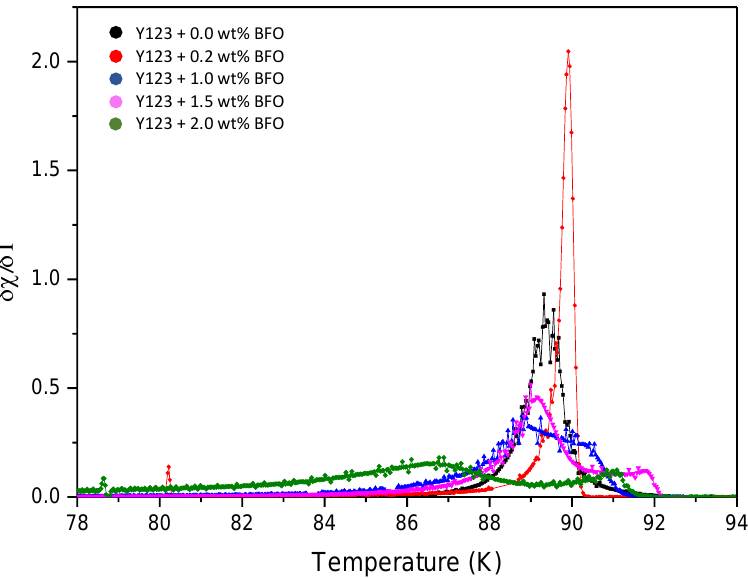
Figure 5. Derivatives of T cj ’s susceptibility δ χ / δ T against the temperature of the Y-123 + x wt.% Figure 5. Derivatives of T cj 's susceptibility δ𝜒/δ𝑇 against the temperature of the Y-123 + x wt.% of of BiFeO 3 . BiFeO 3. Table 3. The coupling peak temperature, T p , onset critical temperature, T c-onset , phase lock-in temperature, T cj , Josephson current, I o , and oxygen deficiency, δ , for the Y-123 + x wt.% of BiFeO 3